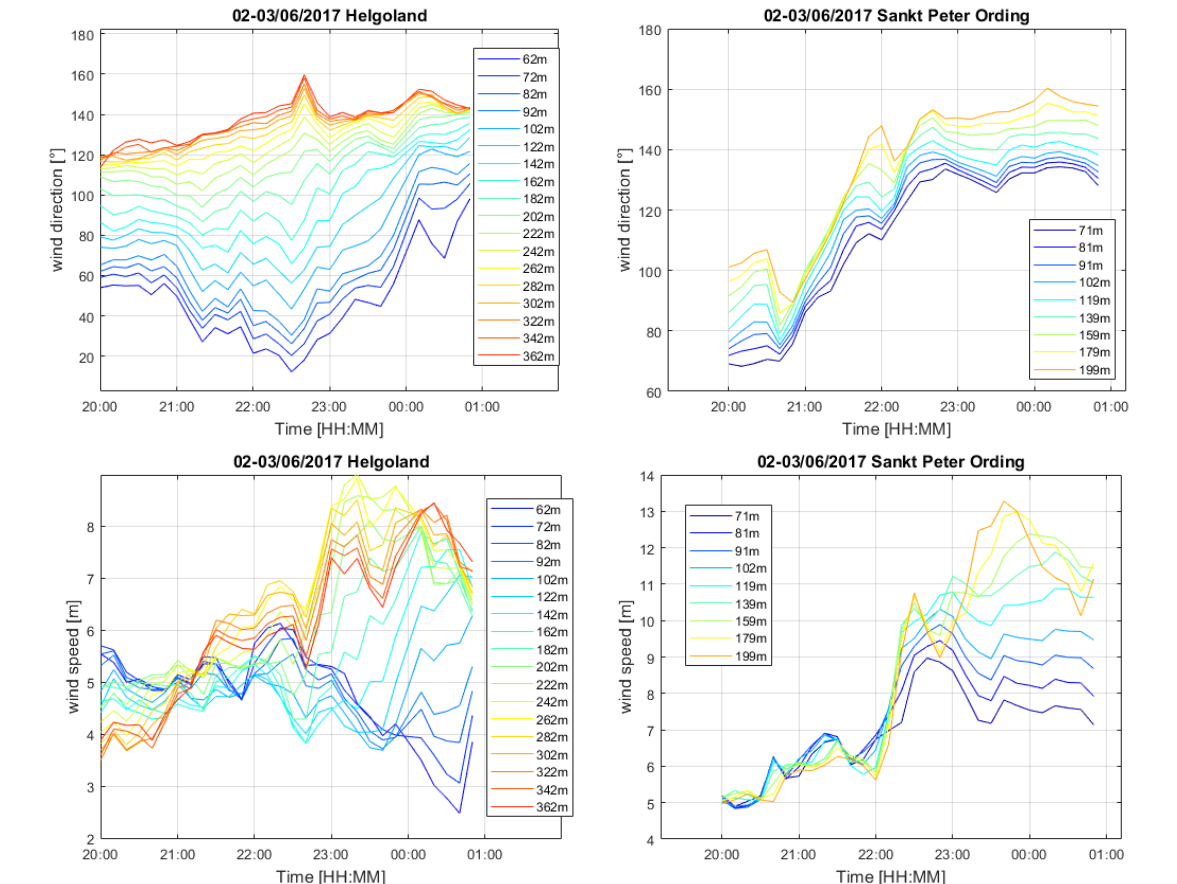
Figure 10. LLJ event on 2 June 2017 late evening, measured at the lidar sites Heligoland and St. Peter-Ording.